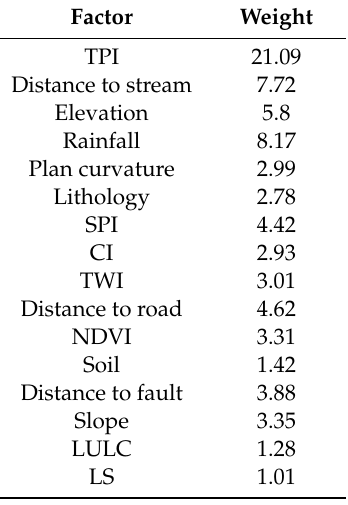
Table 7. The relative influence of landslide conditioning factors in the RF